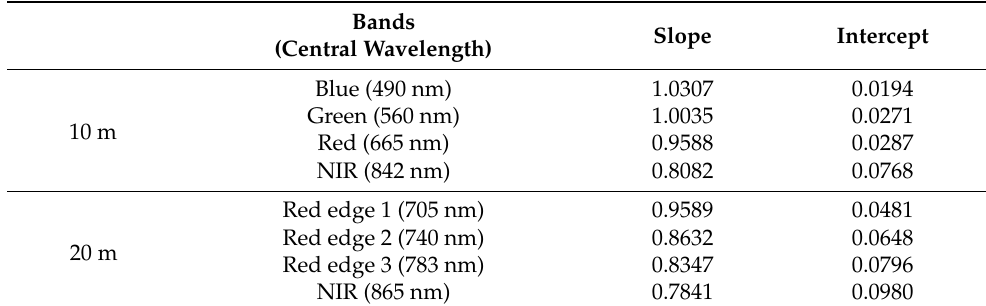
Slope Intercept